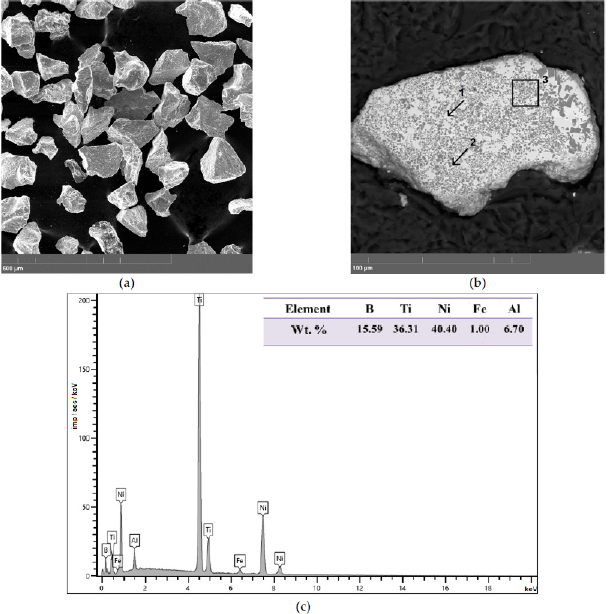
Figure 5. ( a ) SEM image of fine-ground products of combustion of the Ti-NiB system, ( b ) SEM image of the structure of the self-propagating high-temperature synthesis (SHS) powder and ( c ) elementary analysis of SHS powder